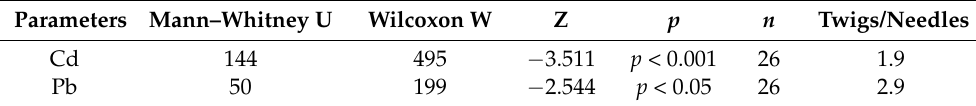
Table 3. The results of statistical analysis (Mann–Whitney U